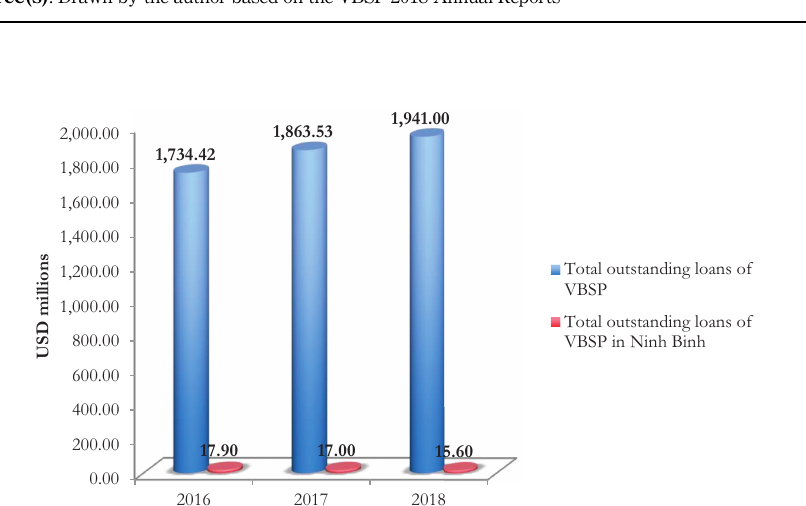
Table 1. Preferential credit programmes provided by the VBSP